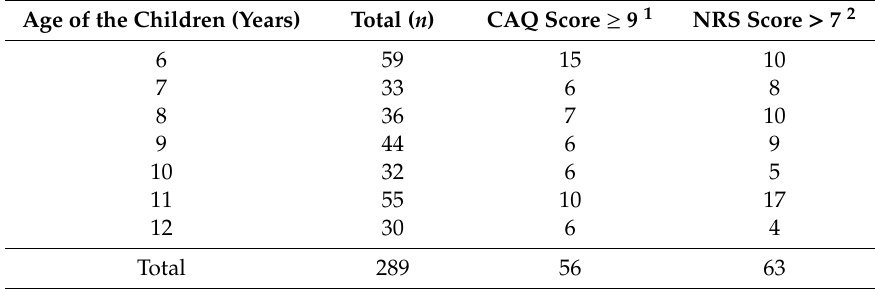
Table 1. Summary of the prevalence (%) of anxiety (Children’s Anxiety Questionnaire (CAQ) score ≥ 9; Numerical Rating Scale (NRS) score > 7) for children by age.